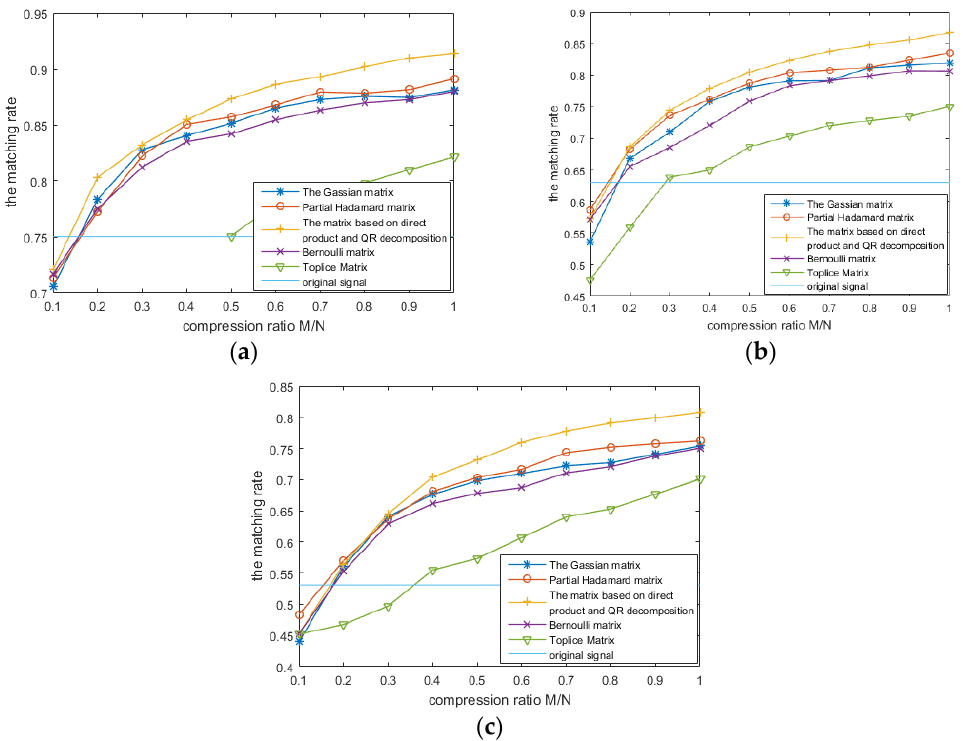
Figure 5. The matching rate comparison using different types of measurement matrices. ( a ) SNR = 4 dB; ( b ) SNR = 0 dB; ( c ) SNR = − 3 dB.